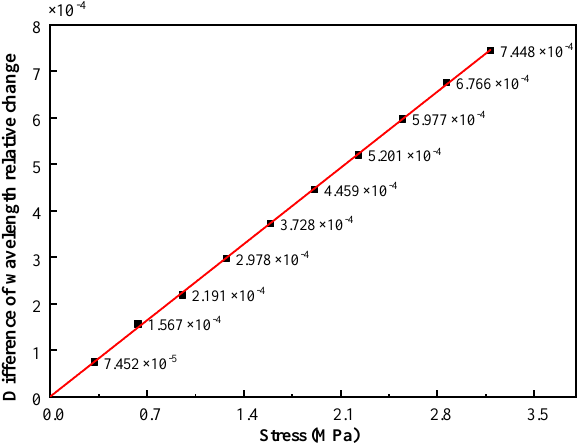
Figure 4. Difference of wavelength relative change within the measurement range.